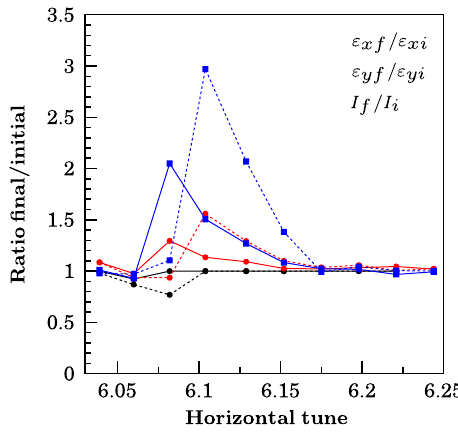
FIG. 9. Simulated growth of horizontal and vertical emittance with the chromaticity set to zero (solid lines), and including natural chromaticity (dashed lines). The simulations are done with MICROMAP.